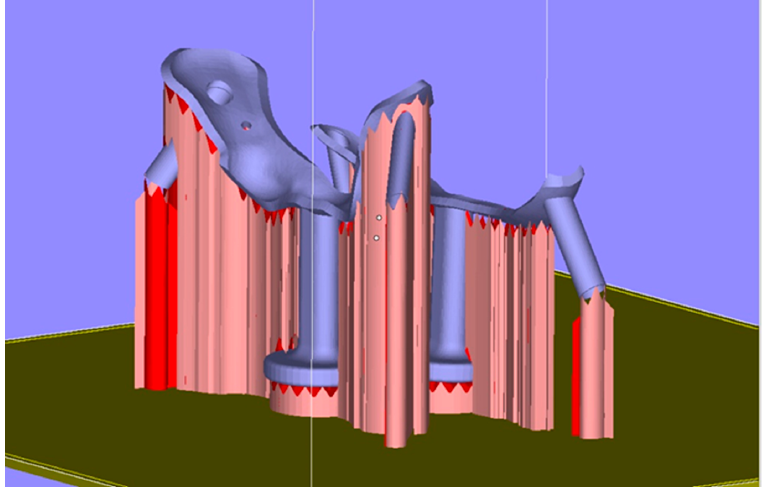
Figure 5. Location adjustment and addition of supports for the surgical template model.